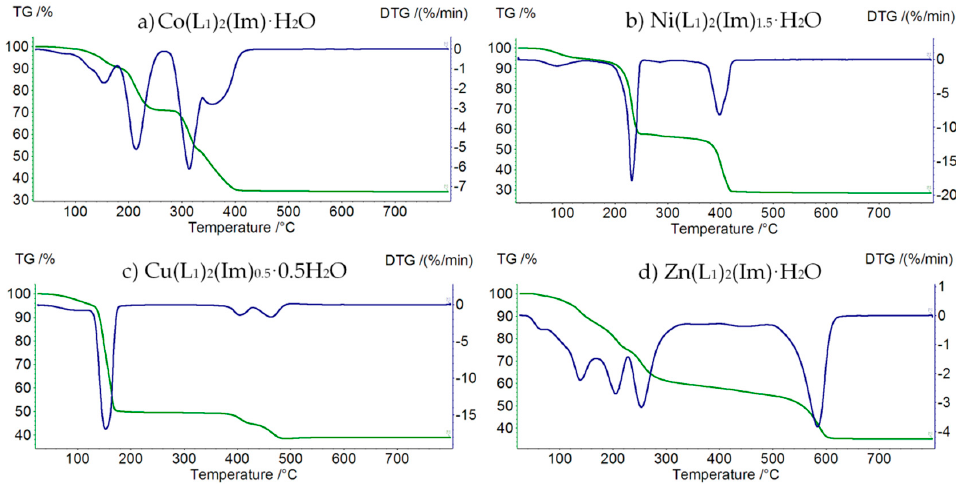
Figure 5. TG (green) and DTG (blue) curves of decomposition of: ( a ) Co(L 1 ) 2 (Im) · H 2 O, ( b ) Ni(L 1 ) 2 (Im) 1.5 · H 2 O, ( c ) Cu(L 1 ) 2 (Im) 0.5 · 0.5 H 2 O, and ( d ) Zn(L 1 ) 2 (Im) · H 2 O.